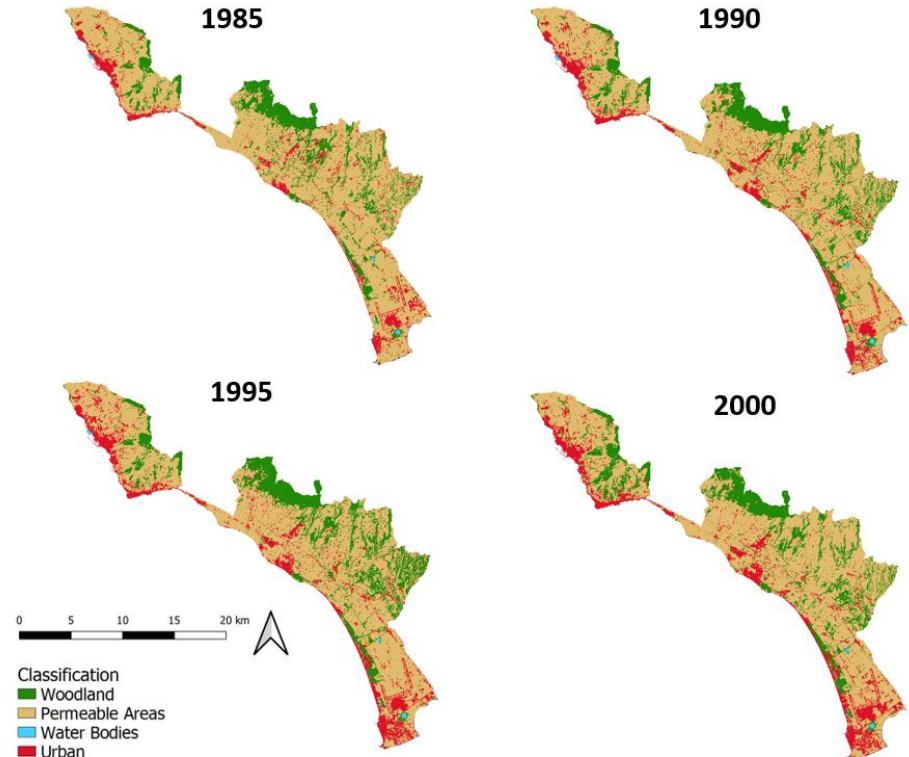
ISPRS Int. J. Geo-Inf. 2023 , 12 , x FOR PEER REVIEW Figure 6. Land cover classification by RF algorithm. Years: 1985, 1990, 1995, and 2000. LC classifica- tions were sieved in QGIS, threshold = 5 pixels, 4-bit connectivity.